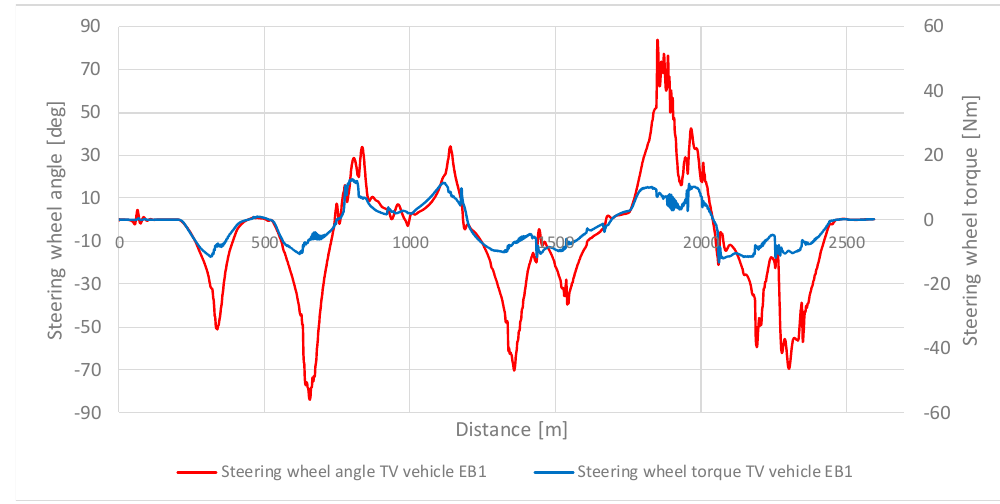
Figure 25. The TV vehicle with EB1 suspension: steering wheel angle (red) and steering wheel torque (blue).